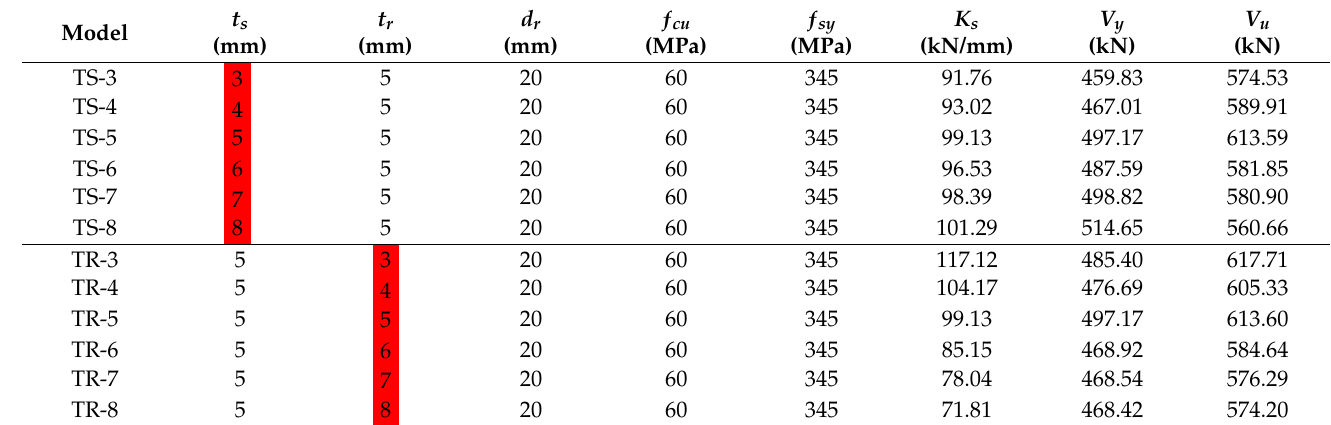
Table 3. Summary of parametric study